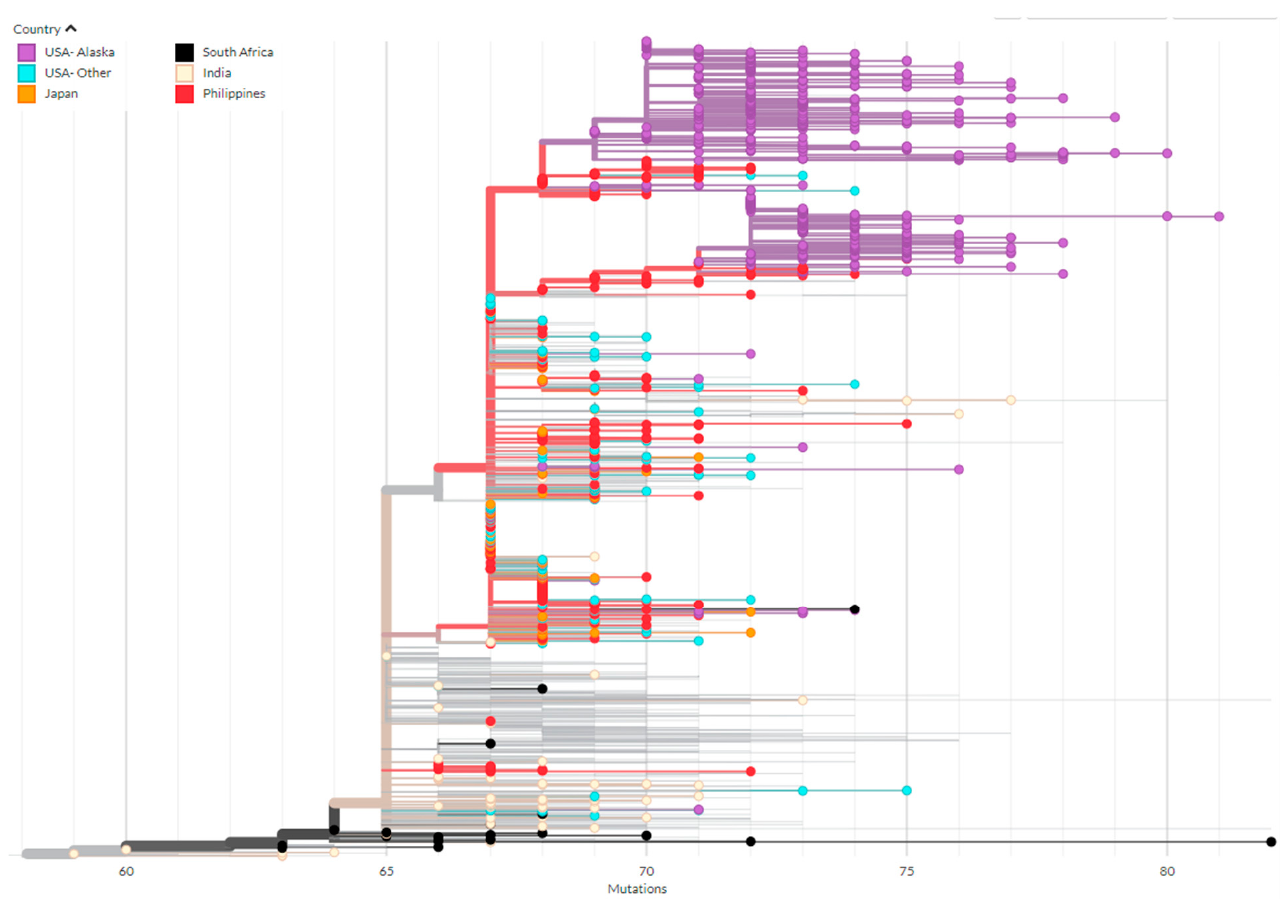
Figure 5. Phylogenetic tree of BA.2.3 cases with branch lengths represented by divergence of cases (number of mutations from Wuhan-Hu-1). Each point is a genome colored by country. Only countries that provide context for Alaska clades and clade origins are included in the visualization.